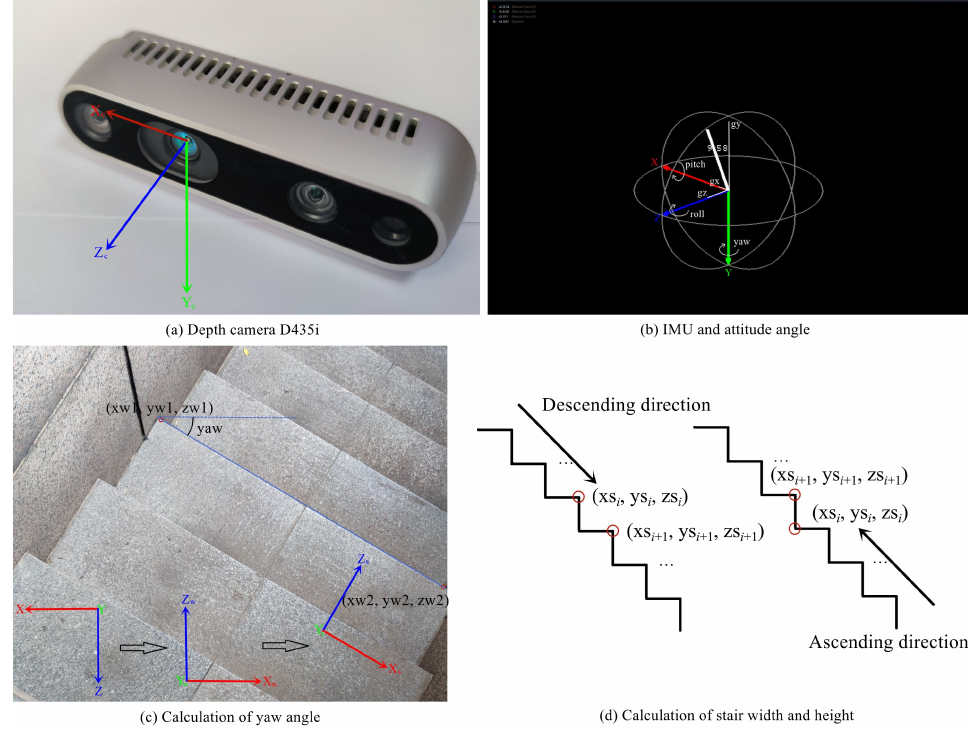
Figure 6. Calculation process of stair width and height. ( a ) shows the Realsense D435i depth camera and the definition of the camera coordinate system. ( b ) shows the definition of the world coordinate system in the IMU module of the D435i depth camera. ( c ) shows the calculation of the yaw angle, which can be calculated through any two points on a stair line in the world coordinate system. ( d ) shows the method of calculating the width and height of stairs in the stair coordinate